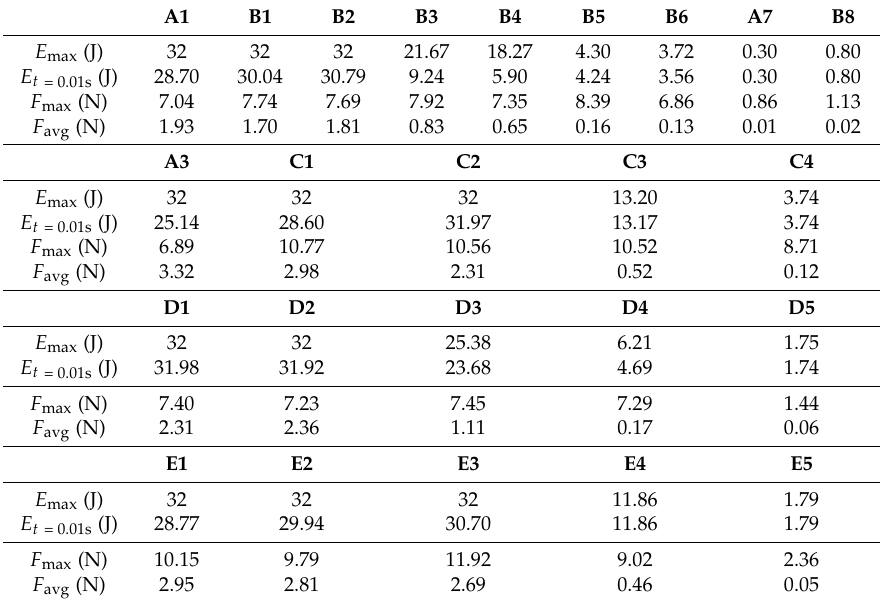
Table 4. The statistics of absorbed energy and contact force.